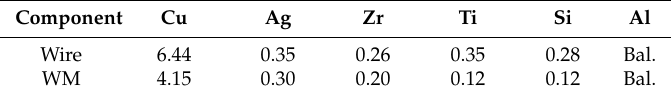
Table 3. Welding conditions and main process parameters. Table 4. Chemical compositions of filler wire and WM of joint